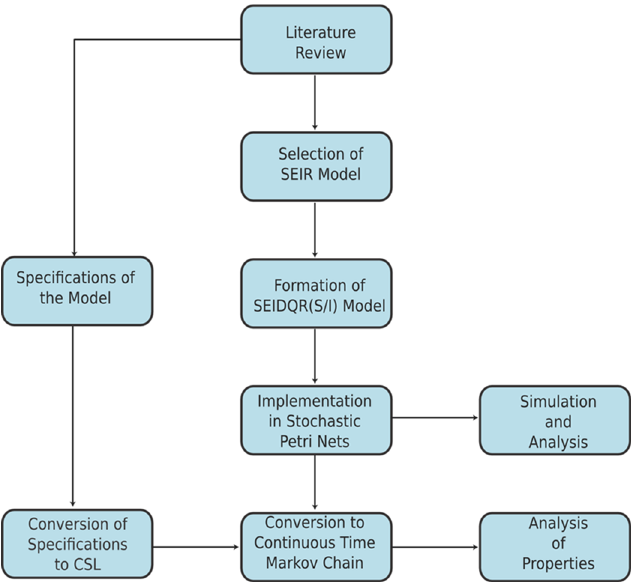
Fig 1. Flow chart of the Proposed Framework. After reviewing literature, SEIR model is selected and a new SEIDQR(S/I) is proposed by modifying SEIR model. SPN of the proposed model is constructed and analysed in Snoopy and Charlie , after which the system is converted to CTMC and specifications are encoded in CSL for quantitative analysis in PRISM model checker.